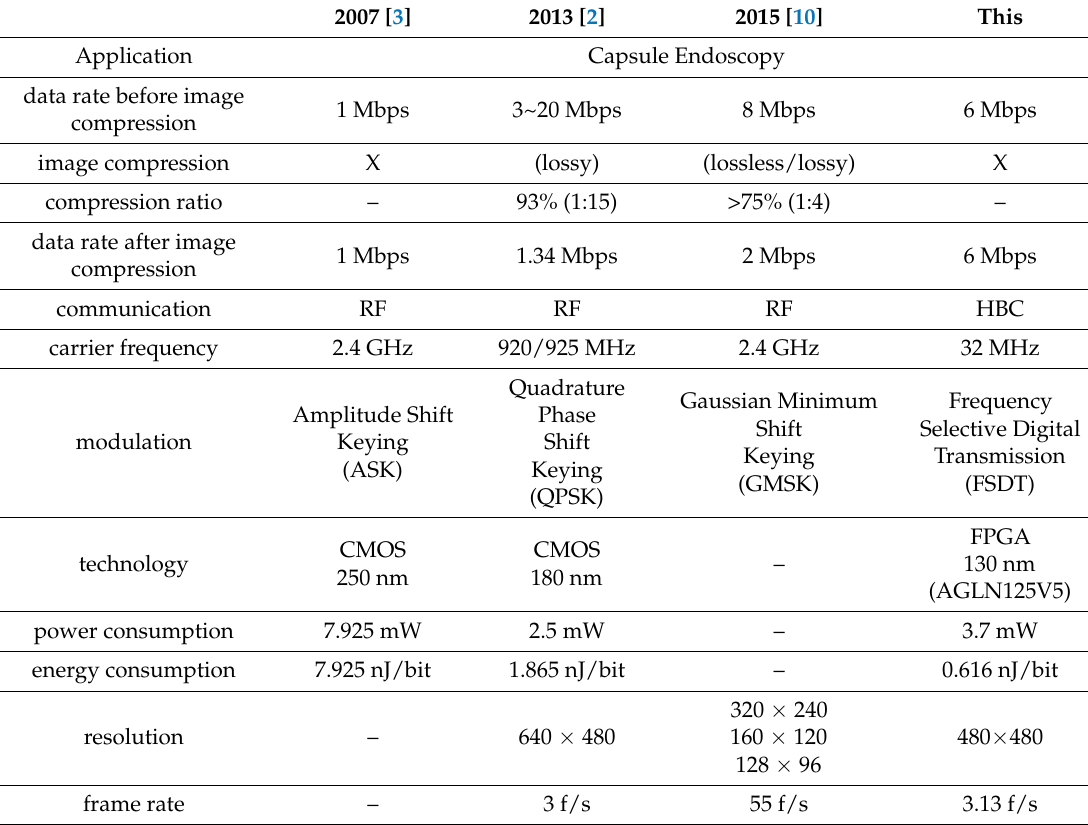
Table 5. Performance comparison of wireless capsule endoscopy (WCE)